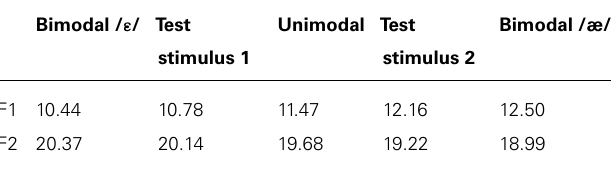
Table 1 | F1 and F2 values (in ERB): means in the unimodal and bimodal training distributions, and values of the two test stimuli. Bimodal / ε /